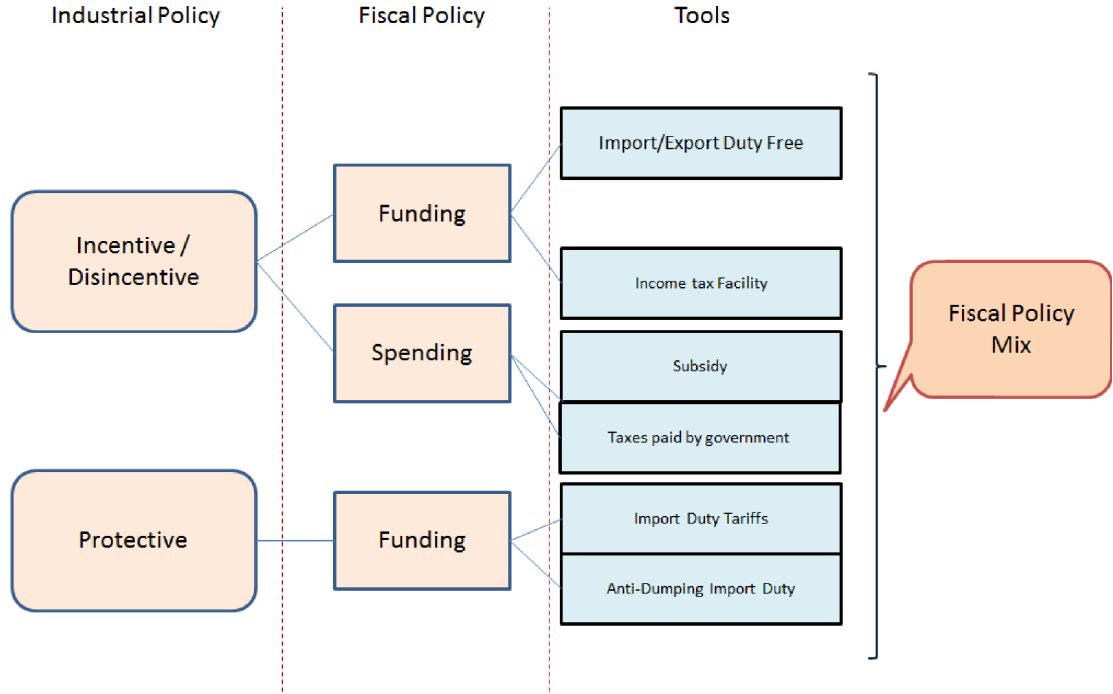
Figure 6. Indonesian Government Fiscal Policy Tools to support